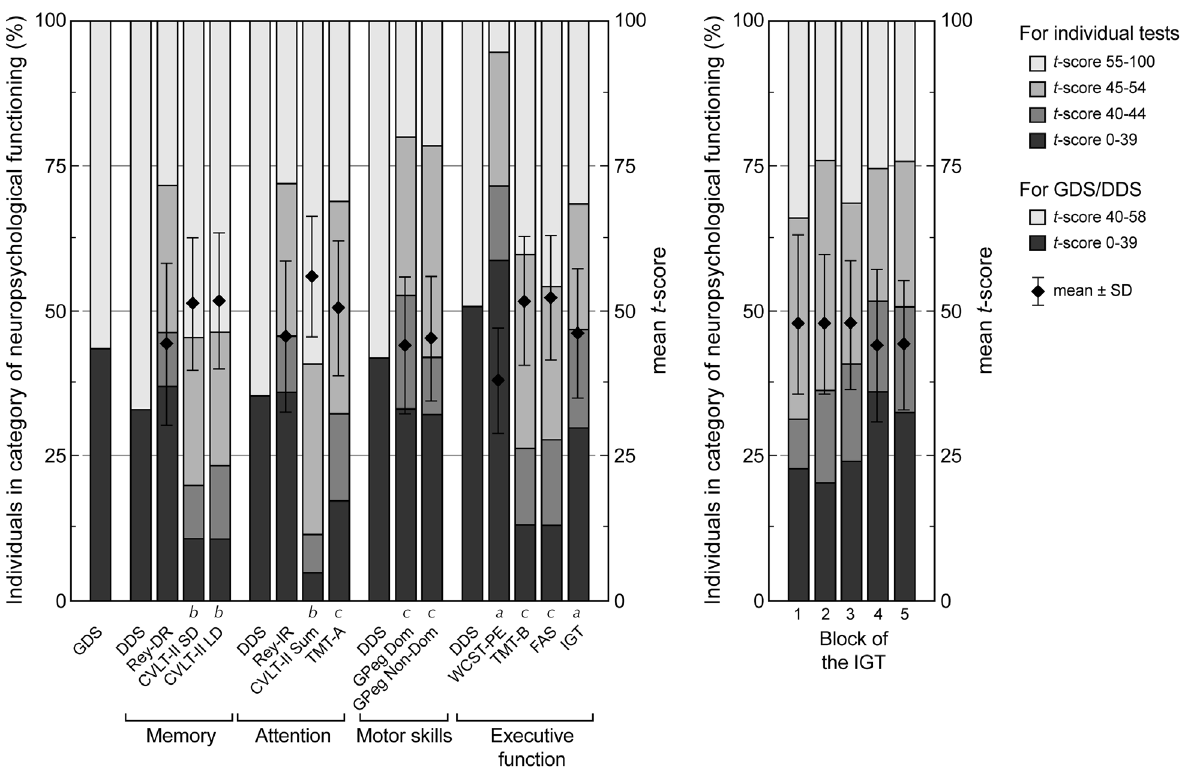
Figure 1. Neurocognitive function at baseline. Left Figure : Results of deficit scores and individual neurocognitive tests. Right Figure : Results of the IGT per subsequent block of the test. The left vertical axis depicts the percentage of individuals in the following categories of neuropsychological function levels: impaired ( t -score 0–39), below average ( t -score 40–44), average ( t -score 45–54), and above average ( t -score 55–100). The right y-axis shows the mean 6 SD of the t -scores for each separate test. Mean and SD for deficit scores are not shown, because these variables exhibited a skewed distribution. Memory was tested by Rey-DR, the CVLT-II SD and the CVLT-II LD. Attention was tested by the CVLT-II Sum and by the TMT-A. Motor skills were assessed by the GPeg Dom and the GPeg Non-Dom. Executive functions were tested by the WCST, the TMT-B and the IGT. For all t -score computations, age was taken into account. In addition, a years of education were taken into consideration for the t -scores for the WCST and IGT, and b gender was taken into account for the CVLT scores. c Education, race, and gender were all taken into account for t -scores of the TMT, GPeg, and